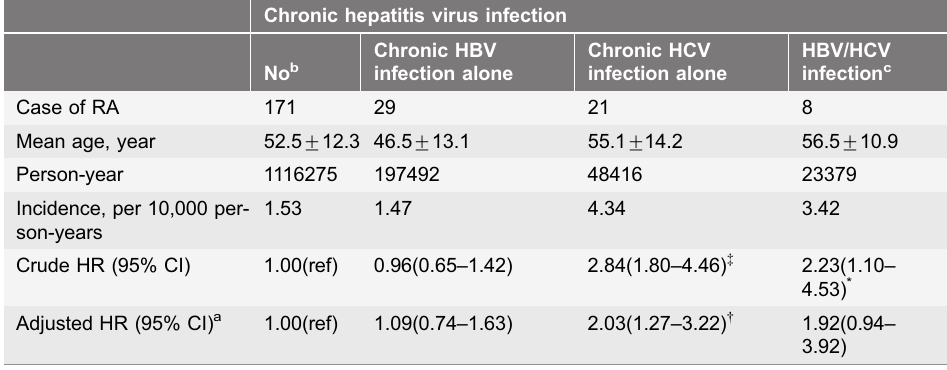
Table 2. Crude and adjusted hazard ratios for rheumatoid arthritis (RA) associated with chronic hepatitis virus infection.